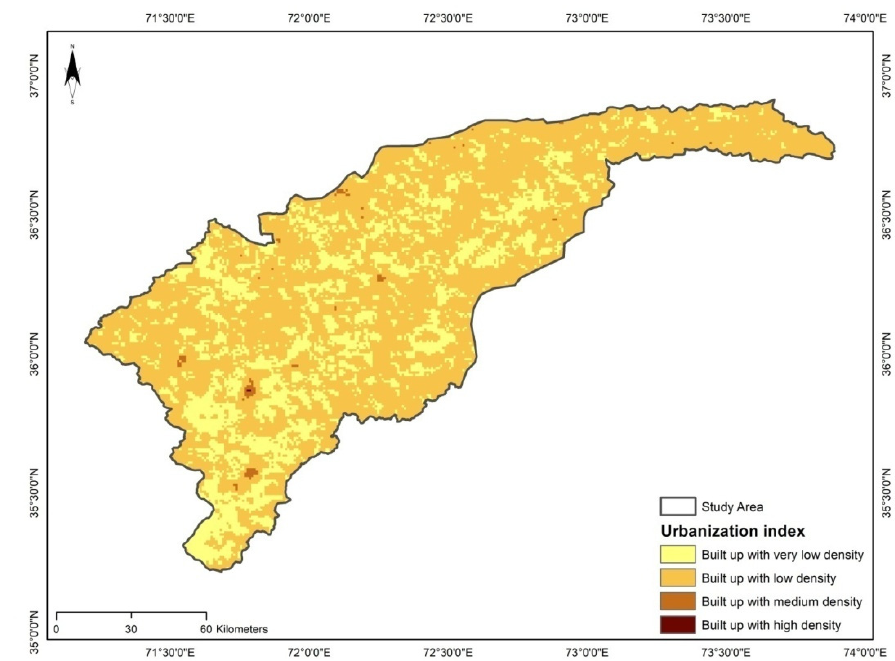
Figure 6. Map showing the urbanization index of study area.